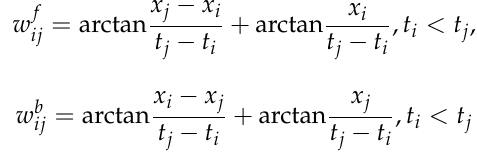
Figure 3. Graphical illustration of FWHVG of the time series. ( a ) Angle measurement of FWHVG; ( b ) Corresponding FWHVG of the time series.